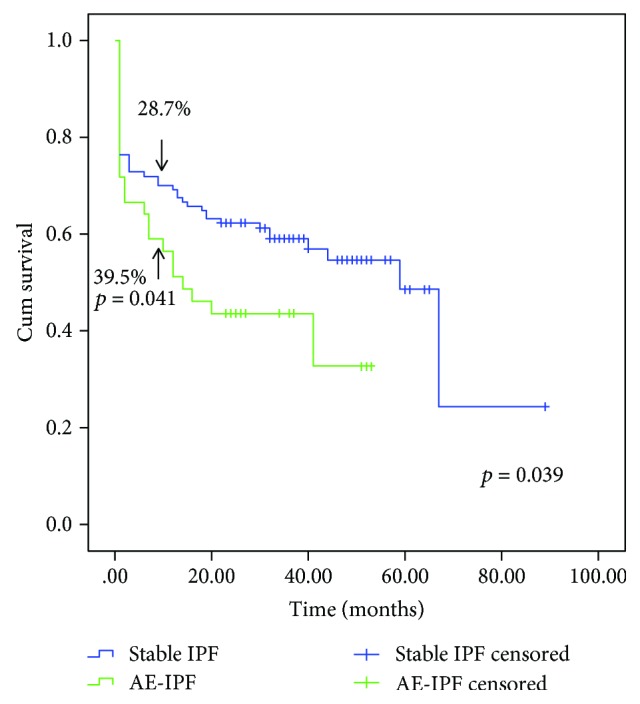
Kaplan-Meier survival analysis showing significantly higher mortality of AE-IPF than IPF (stable IPF) by using the log-rank test (p = 0.039). AE-IPF patients (39.5%) had higher one-year mortality than stable IPF (28.7%) (p = 0.041). In AE-IPF group (23 cases of death), 19 cases died of respiratory failure by acute exacerbation; 4 died of severe pneumonia. In stable IPF group (50 cases of death), 15 died of acute exacerbation in the period of follow-up, 10 died of pneumonia, 5 died of lung cancer, 2 died of liver cancer, 2 died of intestine cancer, 5 died of myocardial infarction, 2 died of gastrointestinal bleeding, 4 died of pulmonary embolism, 3 died of stroke, 1 died of diabetes, and 1 died of trauma.